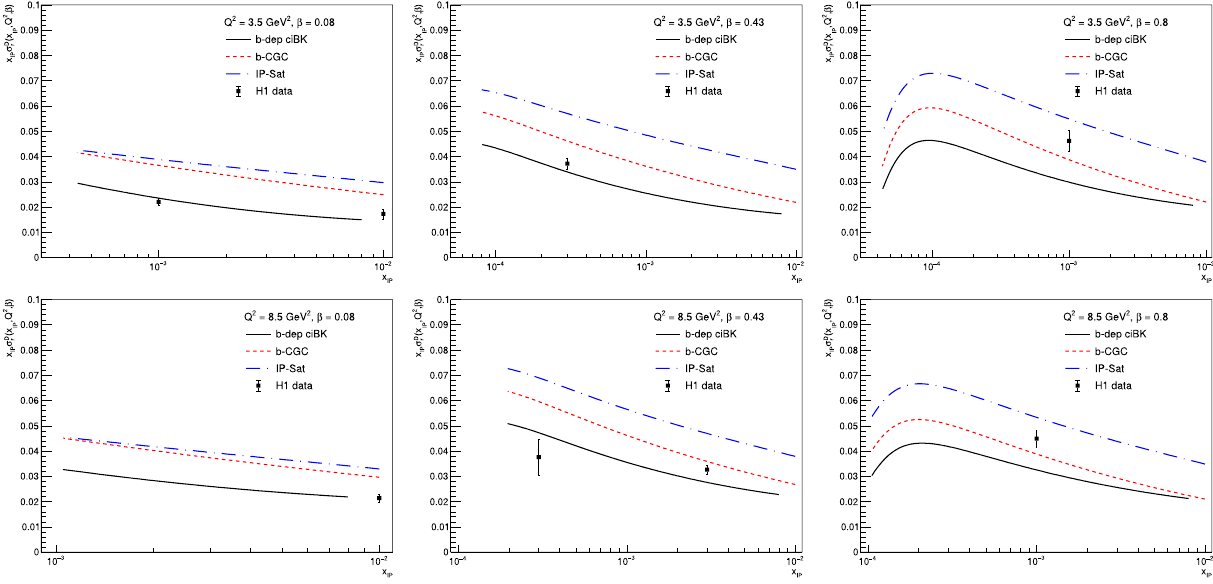
consideringdistinctmodelsforthedipole-protonscatteringamplitude 2